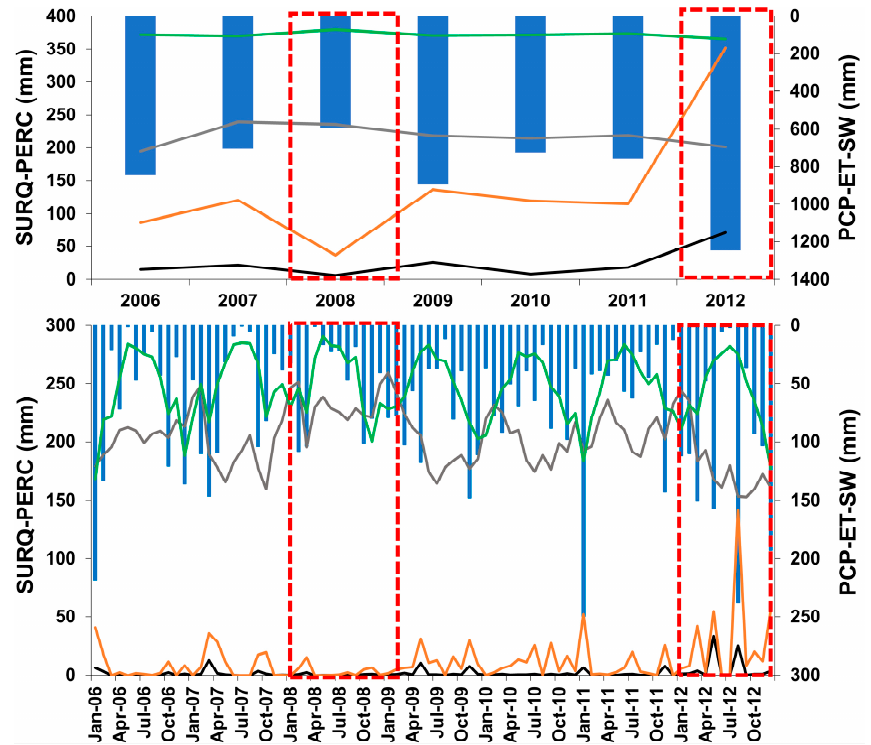
Figure 13. ( top ) Annual and ( bottom ) monthly water balances for the Santa Catalina stream basin. Precipitation (PCP, blue), percolation (PERC, orange), soil moisture (SW, green), surface runoff (SURQ, black) and evapotranspiration (ET, gray), as simulated with SWAT for the 2006–2012 period.